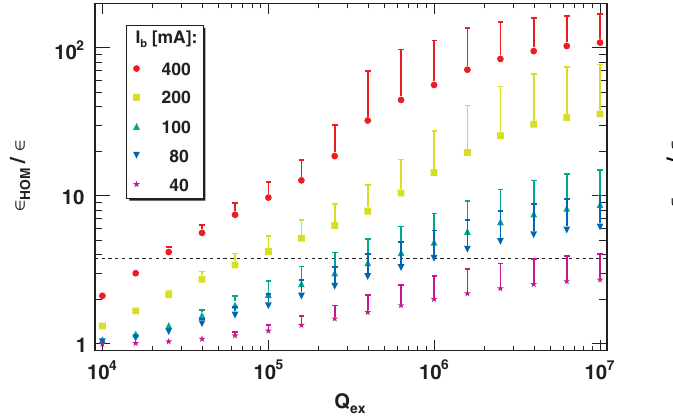
FIG. 24. Average longitudinal phase space increase against the FIG. 22. Average longitudinal phase space increase and upper caused by the TM mode and TM damping Q ex 010 ; 3 = 5 (cid:2) 010 ; 2 = 5 (cid:2) caused by the TM RMS error against the damping Q ex 010 ; 3 = 5 (cid:2) mode and TM mode and a chopped beam, where the 010 ; 2 = 5 (cid:2) mode frequency is shifted to the chopping machine line. The phase space increase due to rf errors is indicated with the dashed i ¼ 699 : 998 MHz , (cid:5) ¼ line. Settings: passband modes, h f n f n 10 kHz , chopping pattern: 50 = 80 , N ¼ 10 , see Table